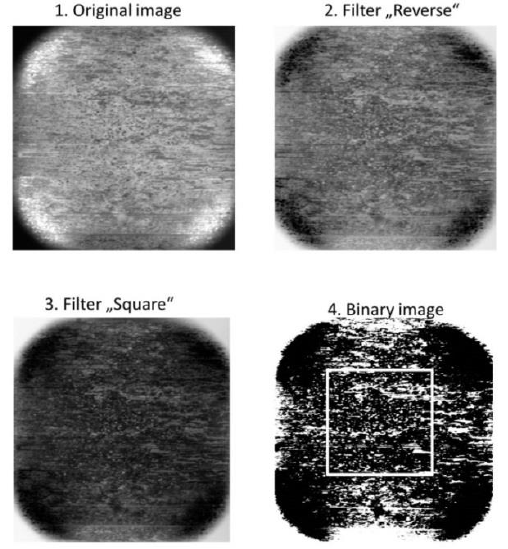
Figure 16. Procedure of the image processing of surface characteristic.